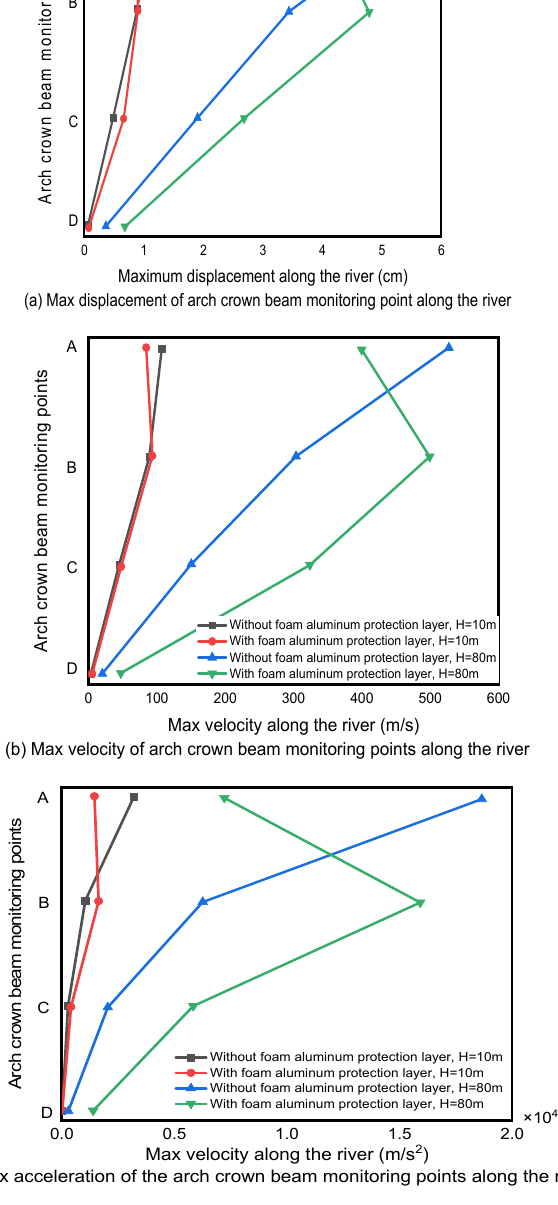
Figure 30. Dynamic response of an arch crown cantilever monitoring point without and with an aluminum foam protection layer.